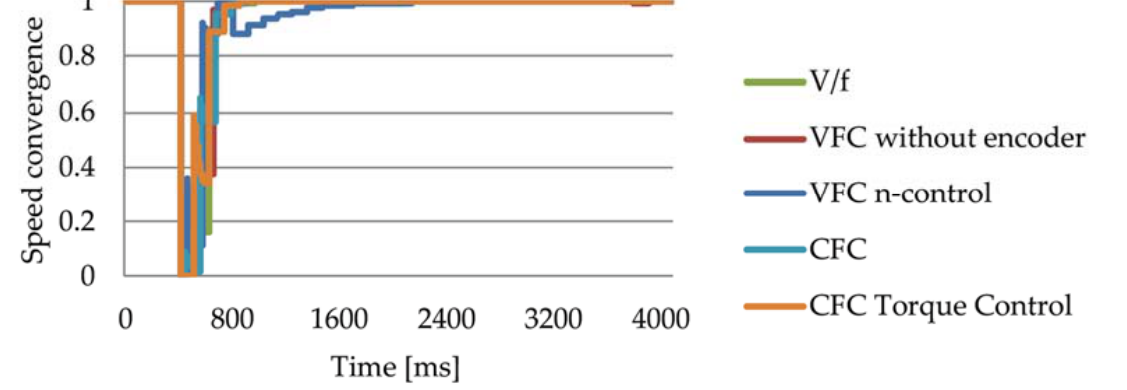
Figure 5. Comparison of the speed convergence (S C ) for various control modes (without an external load). Figure 6 illustrates the E SF values for the investigated drive control modes in the unloaded condition.